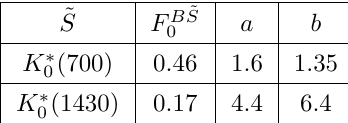
(700), K (cid:3) (1430). 0 0